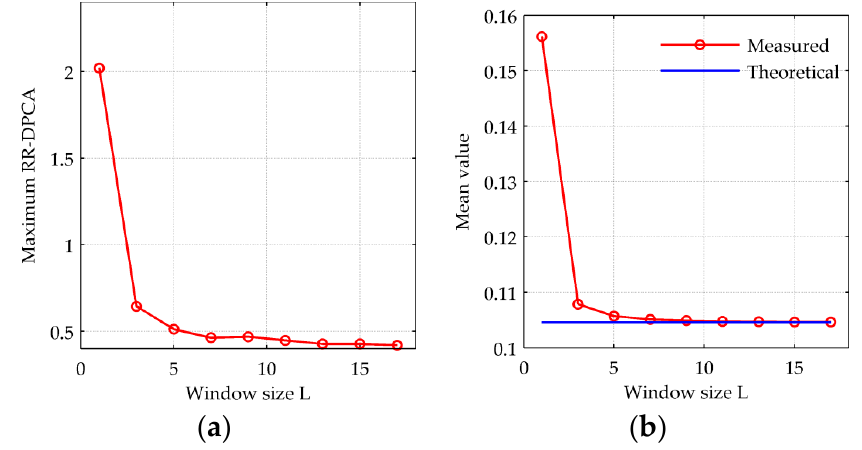
Figure 3. RR-DPCA versus the size of window. ( a ) Maximum RR-DPCA value versus L ; ( b ) Maximum RR-DPCA value versus L .